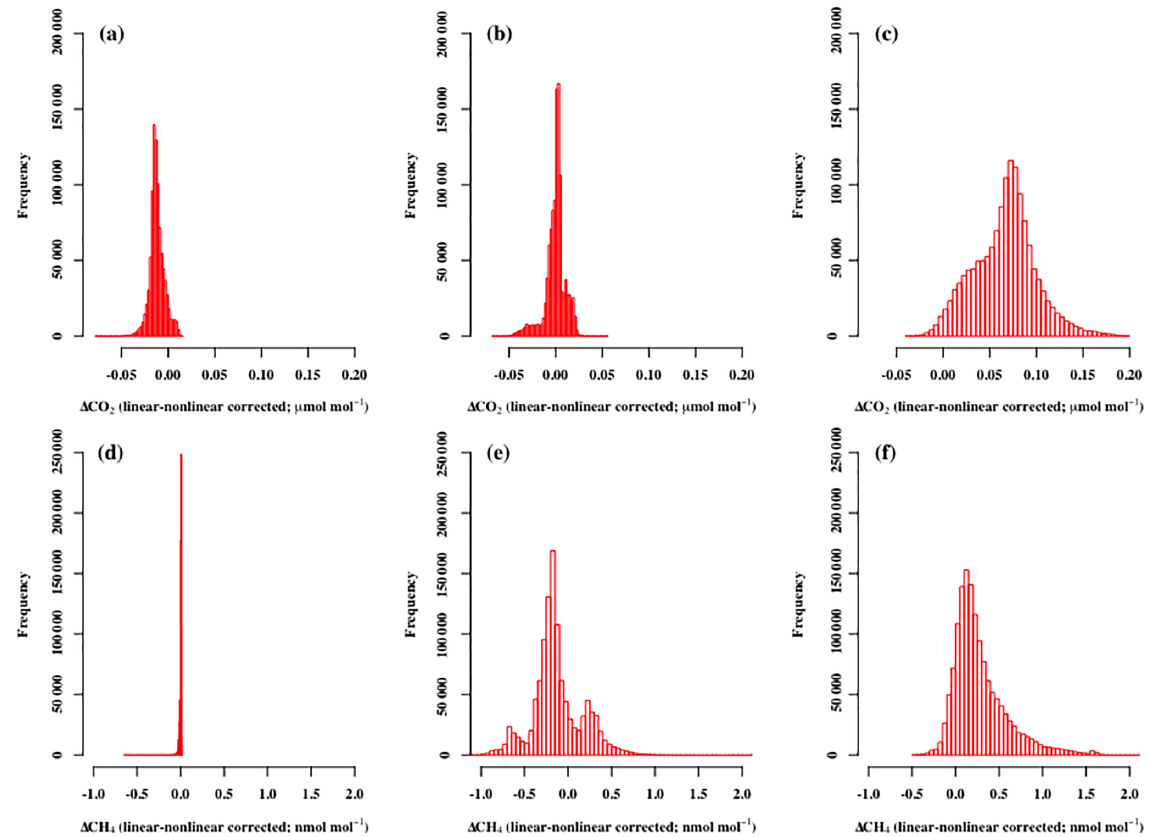
Figure 5. Histograms of the difference between linear corrected data (Eq. 1) and non-linear corrected data (Eq. 2) for CO 2 at (a) RGL, (b) TTA, and (c) TAC, and CH 4 at (d) RGL, (e) TTA, and (f)